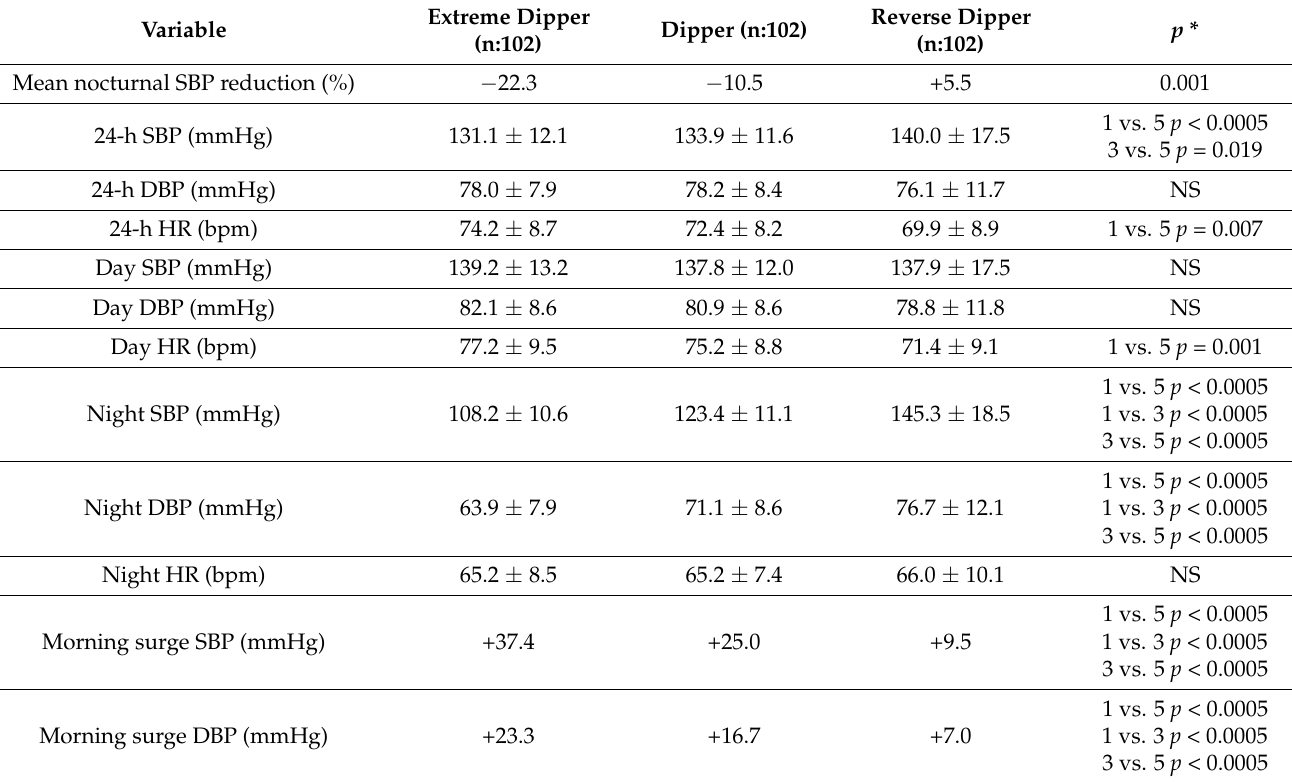
Table 2—Data are presented as mean value ± SD. SBP: Systolic Blood Pressure; DBP: Diastolic Blood Pressure; HR: Heart Rate; SD: Standard Deviation, NS: Not Significant. * Post hoc analysis with the Bonferroni